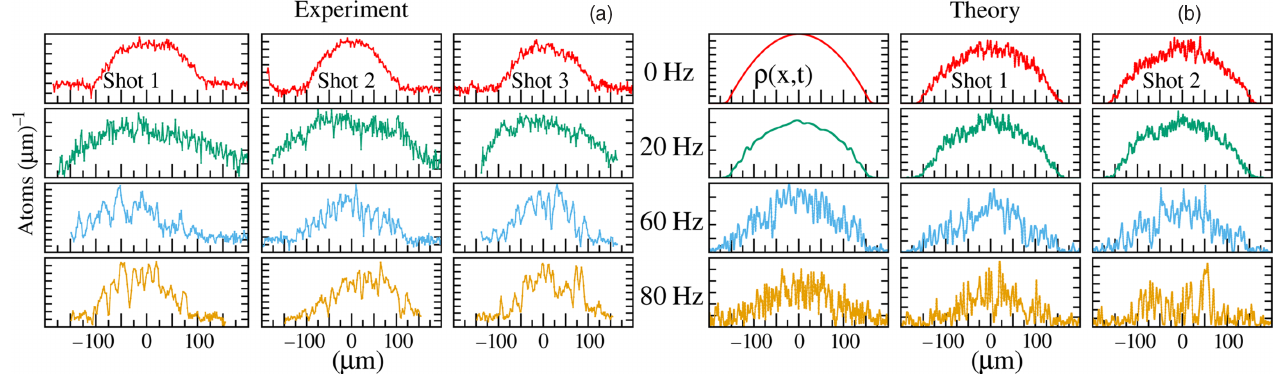
7. Experimental and theoretical line-density profiles. (a) Experimental data and (b) many-body simulations for different modulation frequencies. (a) The rows show data for three independent experimental images ( “ shots ” ) for the indicated ω , where ω ¼ 0 ¯ B ¼ 590 corresponds to no modulation. Here, . 8 G, Δ B ¼ 41 . 3 G, corresponding to ¯ a ¼ 8 a 0 , a þ ¼ 20 a 0 , a − ¼ 0 . 7 a 0 , and ¼ t ¼ 250 ms. (b) The first column shows the density ρ ð z; t Þ as calculated from the 1D MB theory (see Methods), while the t m h second and third columns display two simulated single shots. We observe that granulation is present in the single-shot images but absent in the average, ρ ð x; t Þ